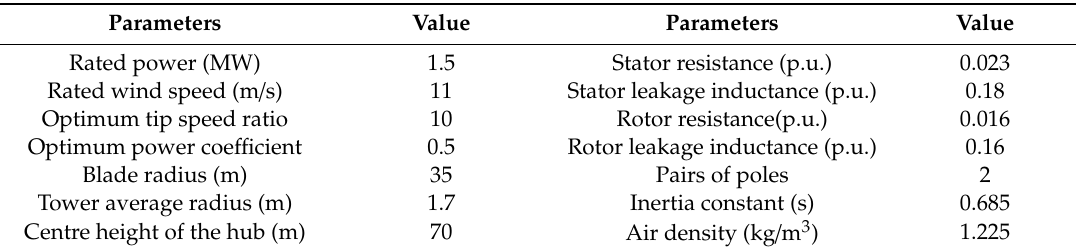
Table 1. Parameters of 1.5 MW doubly-fed induction generator (DFIG) wind turbine.